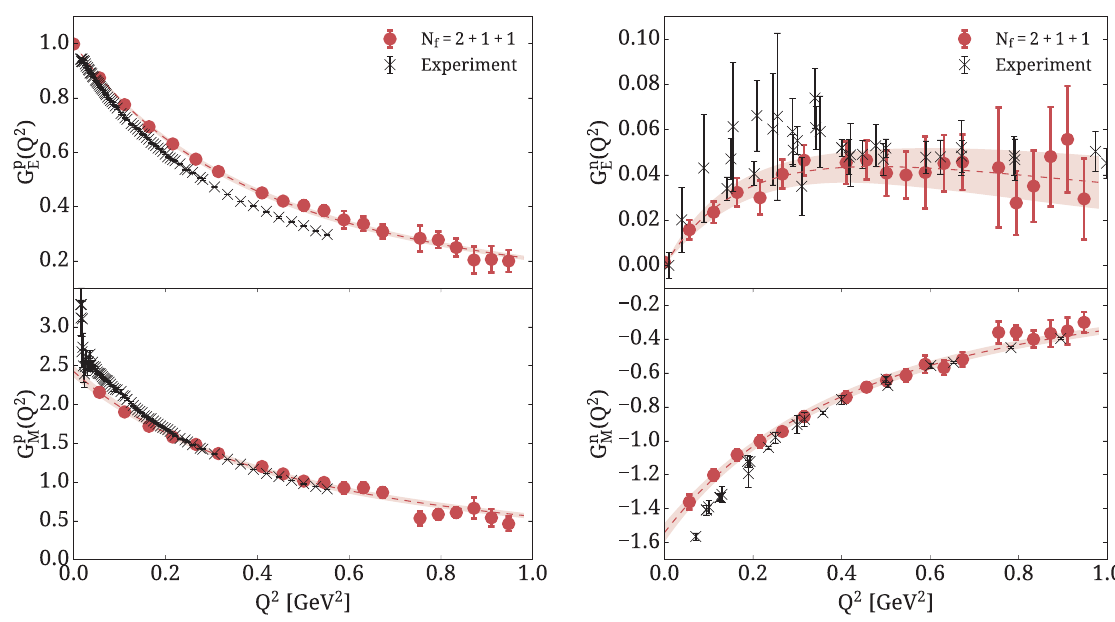
Figure 8. Electric (top) and magnetic (bottom) form factors of the proton (left) and neutron (right) from Ref. [9], compared to